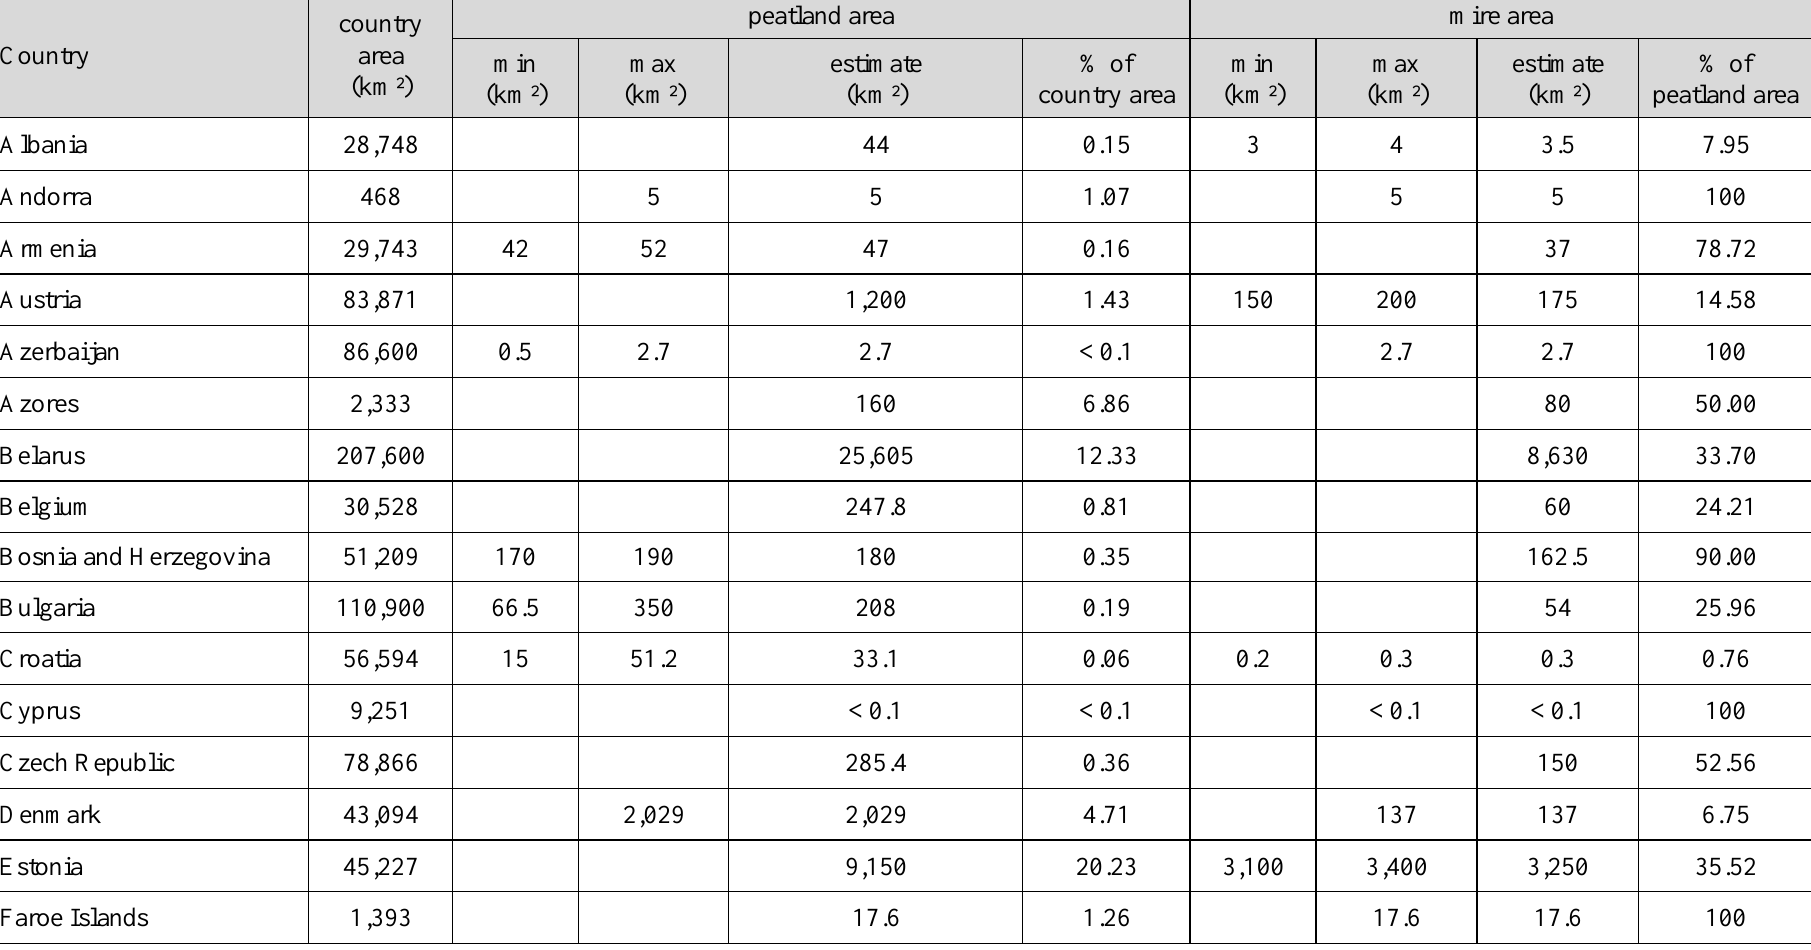
Table 1. Estimated peatland and mire areas per country (in km²), as in Joosten et al. (2017a); also expressed as fractions (%) of, respectively, the country’s surface and total peatland areas. Unless otherwise indicated, the data refer to areas with a minimum peat thickness of 30 cm. The country areas are total surface areas, including land and inland water bodies but excluding polar regions and uninhabited islands, from UNSD (2012) except for European Russia. Superscripted numbers refer to notes located below the